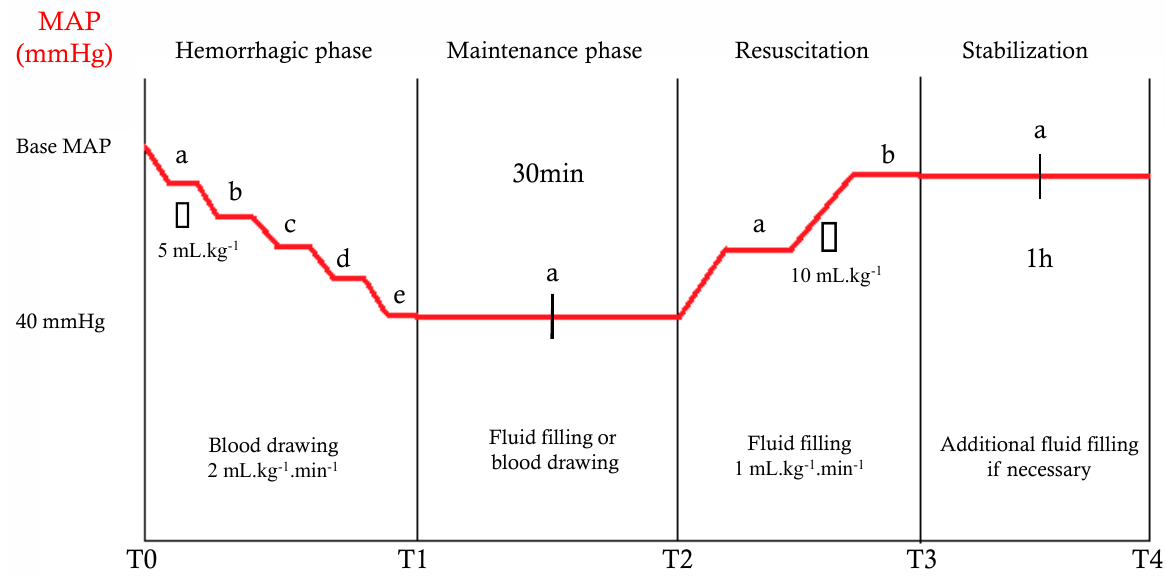
Figure 1. Study design. MAP = mean arterial pressure.